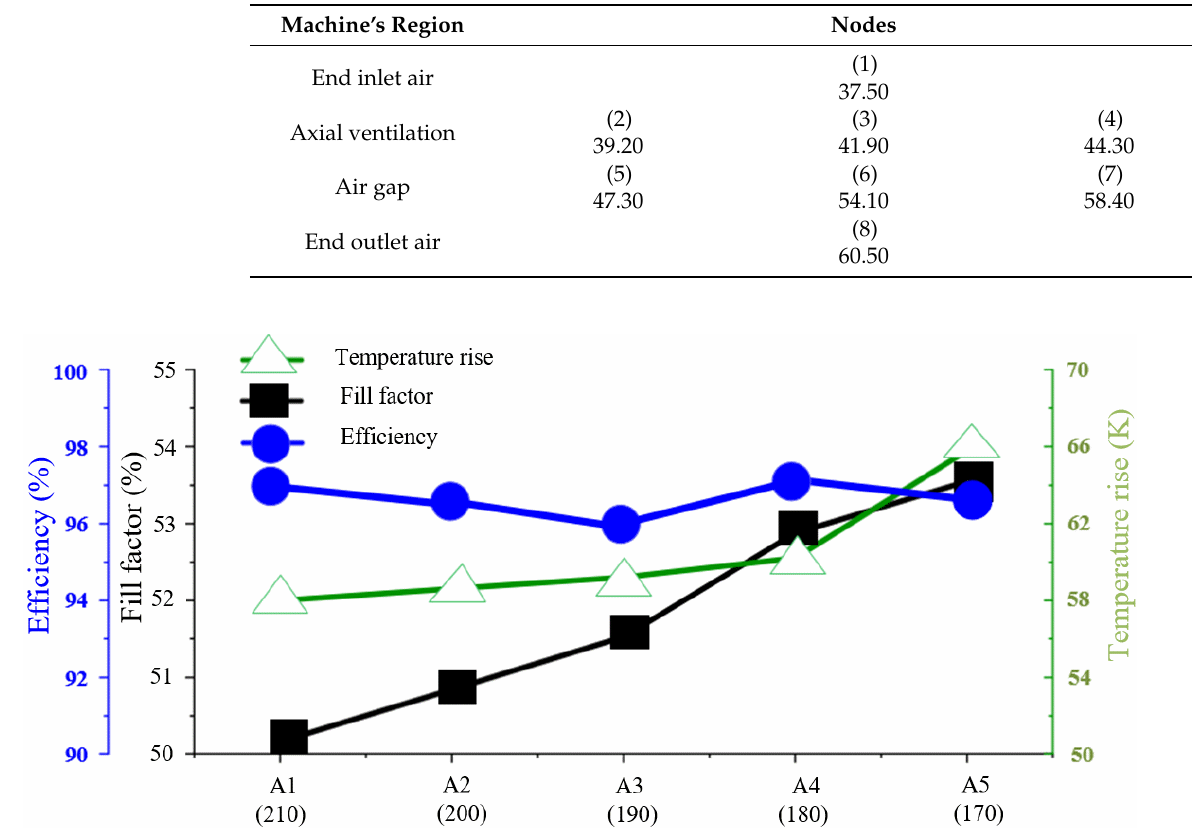
Figure 13. Relationship between analytical axial model ′ s lengths with fill factor, efficiency, and end winding rise in temperature. Table 8. Summary of the machine ′ s slot winding sensitivity analysis.